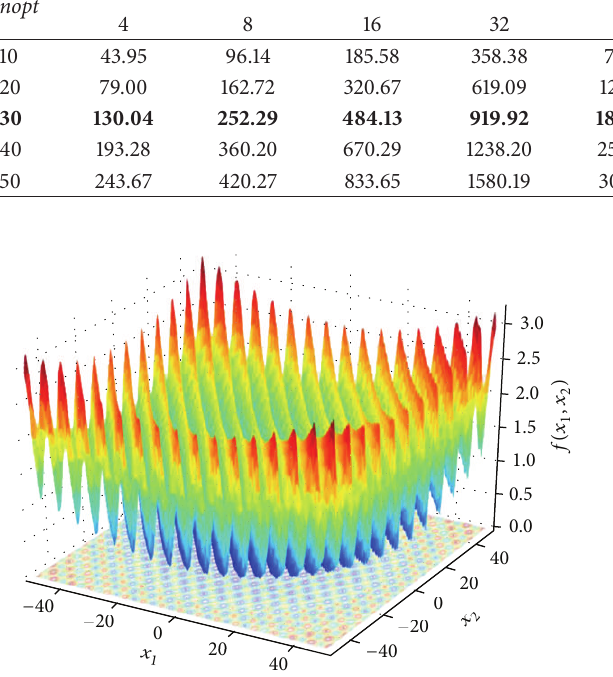
Figure 3: The two-dimensional Griewank